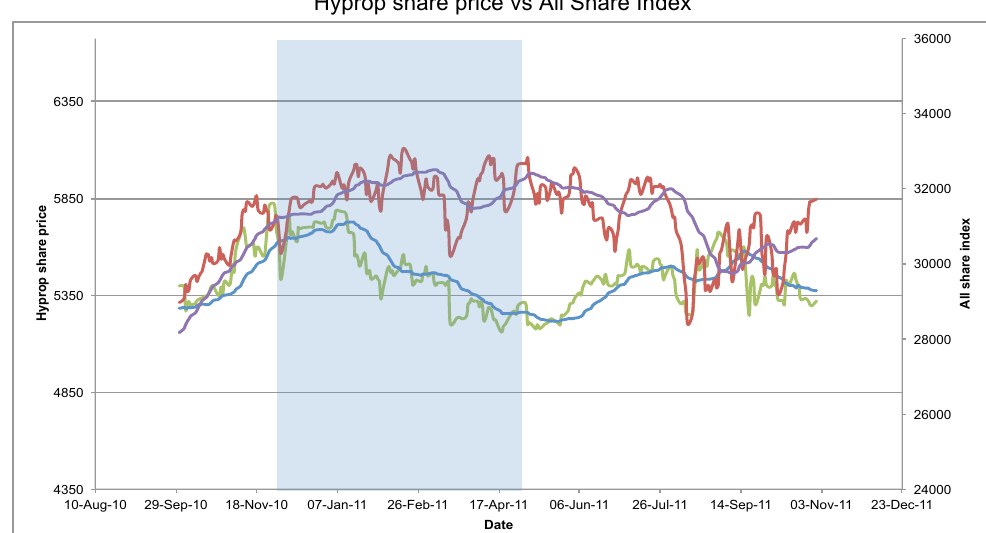
Hyprop share price vs All Share Index